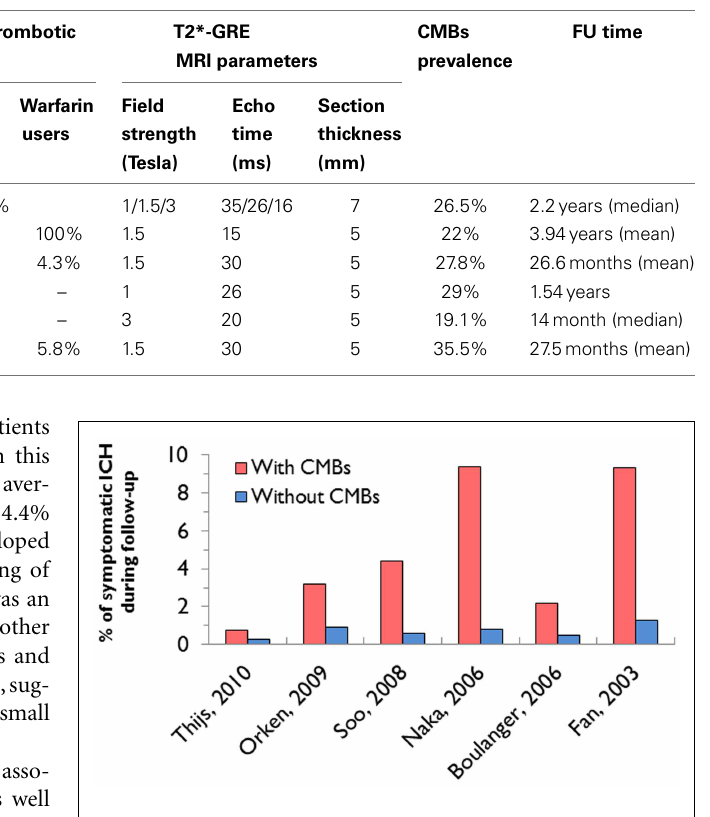
FIGURE 5 | Incidence of intracerebral hemorrhage in relation to the presence of cerebral microbleeds (CMBs) in the main prospective cohort studies which have assessed this risk in patients with ischemic stroke orTIA (Table 3).